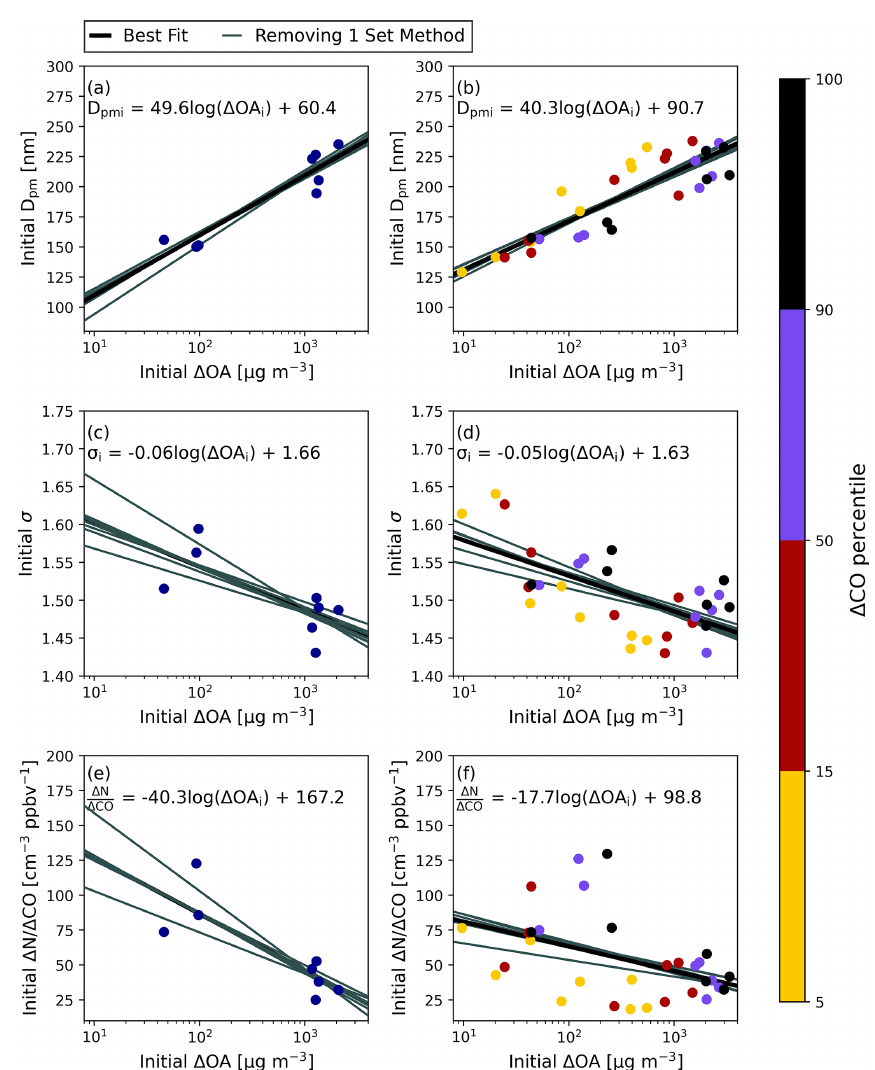
Figure 3. Initial D pm versus initial (cid:49) OA i in the transect averages (a) and (cid:49) CO percentiles (b) . Initial σ versus initial (cid:49) OA i in the transect averages (c) and (cid:49) CO percentiles (d) . Initial (cid:49)N/(cid:49) CO versus initial (cid:49) OA i in the transect averages (e) and (cid:49) CO percentiles (f) . In each panel, the best-fit line for the points is shown in solid black, with the equation of this line shown in the panel. The gray lines are the results of linear regressions with one set of transects removed at a